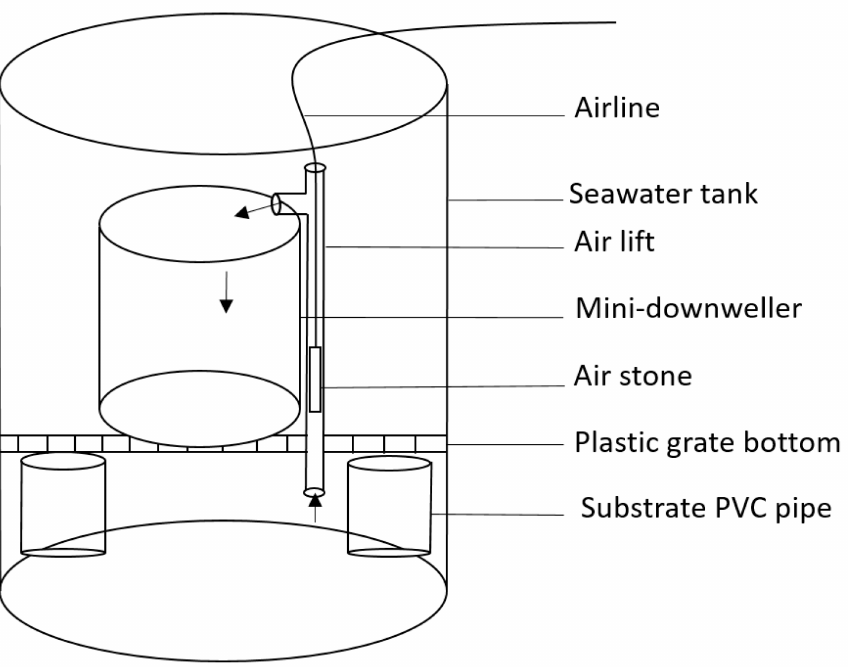
Figure 1. Diagram of experimental post-set rearing system used in both feed studies. Arrows indicate the direction of seawater flow through airlift and downweller (figure reproduced from